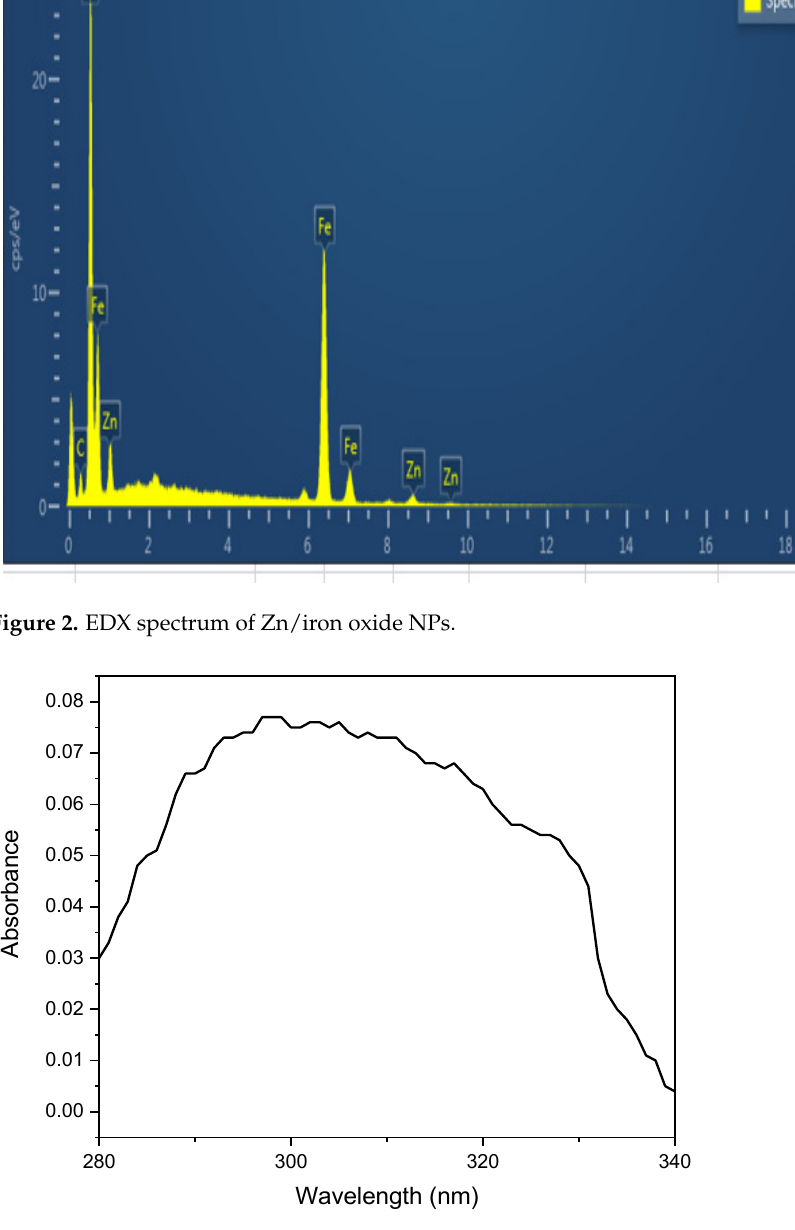
Figure 3. Spectral characteristics of photocatalyst.